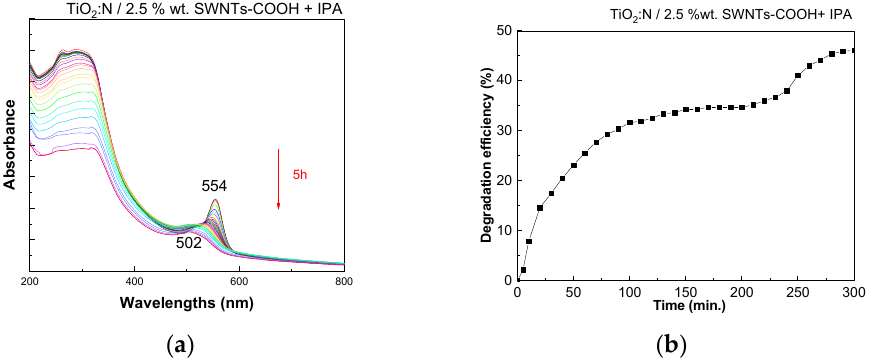
Figure 14. UV–VIS absorption spectra of the RhB aqueous solution containing the SC sample and IPA, recorded by the successively exposure to UV light, time of 300 min (5 h) ( a ), and the degradation efficiency as a function of the UV irradiation time ( b ).